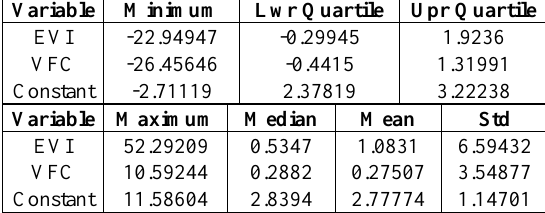
Table 1. The range change of parameters from GWR model